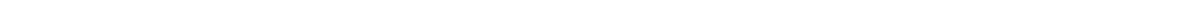
Fig. 3 Enhanced effector function of Grail − / − CD8 + T cells in vitro and in vivo. a CD45.1 + congenic mice were inoculated with EG-7 tumours and, CD45.2 + OT-I or Grail − / − OT-I cells were transferred 5 days later. Eight days after OT-1 transfer, TILs were isolated and stimulated with OVA peptide stained for IFN- γ and granzyme B (GzmB), and analysed in CD45.2 + CD8 + gate. The bar graph shows mean ± SEM as well as the percentage from individual mice per group ( n = 6 mice from two experiments). b Mixed bone marrow chimeric mice were inoculated with EG-7 tumour cells. TILs were stimulated as in a and analysed for IFN- γ and GzmB production in CD45.2 − CD8 + (WT) or CD45.2 + CD8 + ( Grail − / − ) gate. The bar graph shows mean ± SEM as well as the percentage from individual mice per group ( n = 10 mice from two experiments). c FACS-sorted naive CD8 + T cells were activated with anti-CD3 alone or together with anti-CD28. Three days later, expression of IFN- γ and GzmB was analysed by intracellular staining. N = 3 independent experiments. d Naive OT-I and Grail − / − OT-I cells were activated with OVA peptide and irradiated WT APCs. Two days later, expression of IFN- γ and GzmB was analysed by intracellular staining. N = 3 independent experiments. e Two days after activation with OT-I peptide, WT and Grail − / − CD8 + T cells were incubated with 1 µ g/ml OVA peptide-pulsed EL-4 cells labelled with DDAO-SE for 2 h. The cells were fi xed, permeabilized and stained with anti-cleaved caspase-3 mAb. N = 3 independent experiments. f Spleen cells from OT-I or Grail − / − OT-I mice were adoptively transferred into C57BL/6J mice ( n = 3 mice per group) followed by s.c. vaccination with OVA peptide and anti-CD40. Imiquimod cream was applied on the vaccination site. In addition, mice received 100,000 IU rhIL-2 by i.p. Three days after vaccination, mice were injected with a 1:1 mix of target cells loaded with 1 µ g/ml peptide and labelled with 5 µ mol/l CFSE